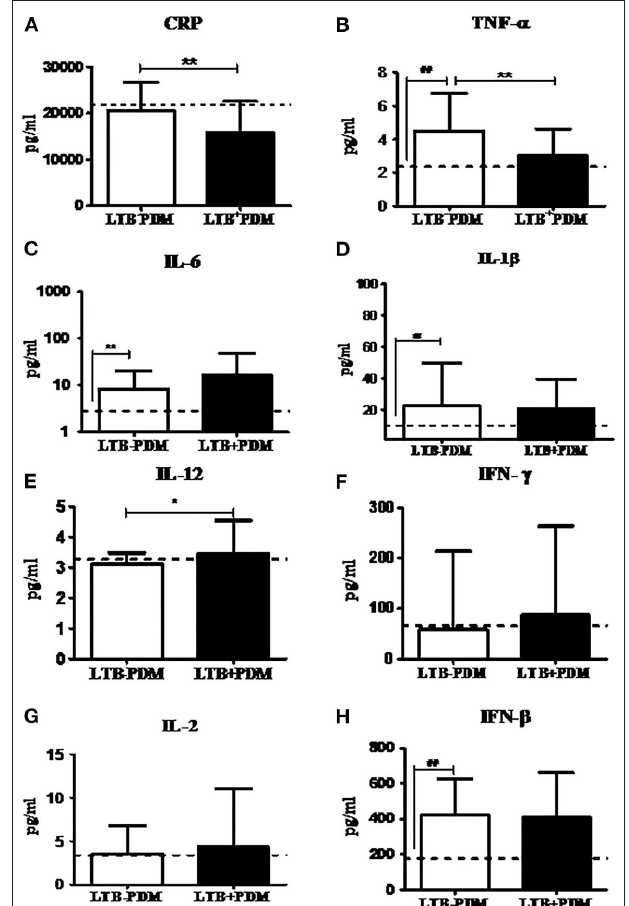
FIGURE 2 | Prevalence of LTBI was significantly decreased among NDM and PDM groups compared to NGT and KDM groups, while the prevalence is significantly increased among the hypertensive groups. The study subjects were stratified based on Age (A) , Gender (B) , Diabetes (C) , Hypertension (D) , BMI (E) and Dyslipidemia (F) and the percentage of LTB − and LTB + subgroups, within each group were plotted. P < 0.05 was considered significant. P -value and OR[95%CI] were calculated using chi-square analysis and binary regression analysis, respectively. LTB, Latent Tuberculosis; BMI, Body Mass Index; SBP, Systolic Blood Pressure; DBP, Diastolic Blood Pressure; FPS, Fasting Plasma Glucose; PPPG, Post Prandial Plasma Glucose; HbA1c, Glycated Hemoglobin; HDL, High Density Lipoprotein; LDL, Low Density Lipoprotein; VLDL, Very Low Density Lipoprotein; TC, Total Cholesterol; TGL, Triglyceride lipids; NS, Non-significant.